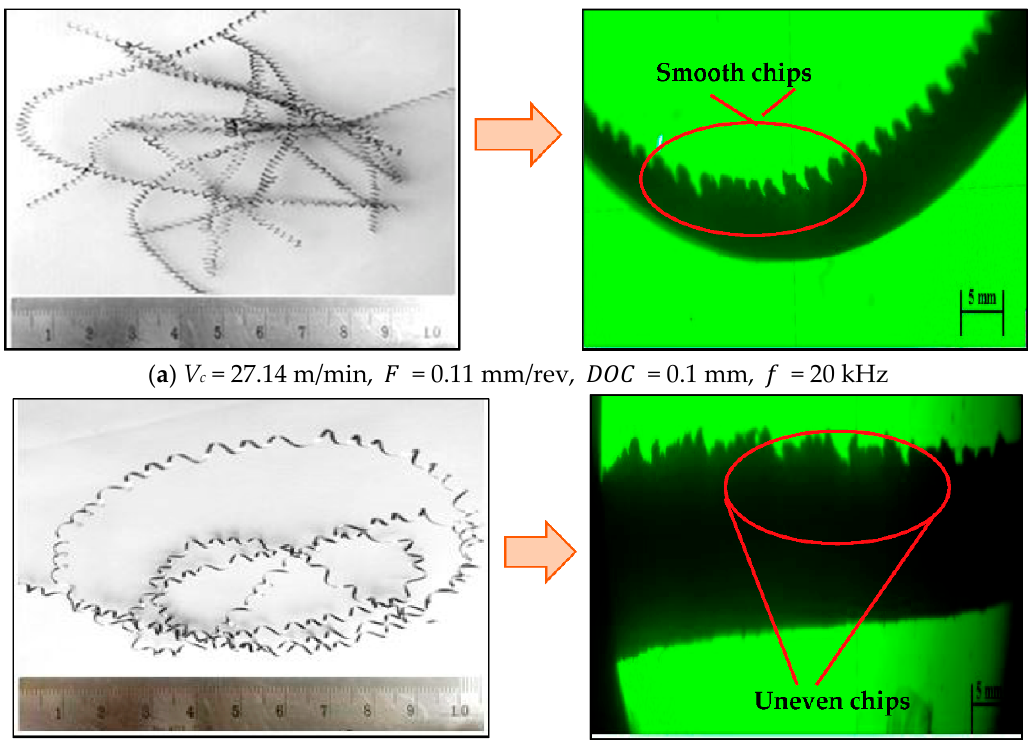
Figure 4. Macrographs and chip formed during machining of Nimonic-90 alloy under different conditions, ( a ) smooth and short chips, ( b ) longer chips.